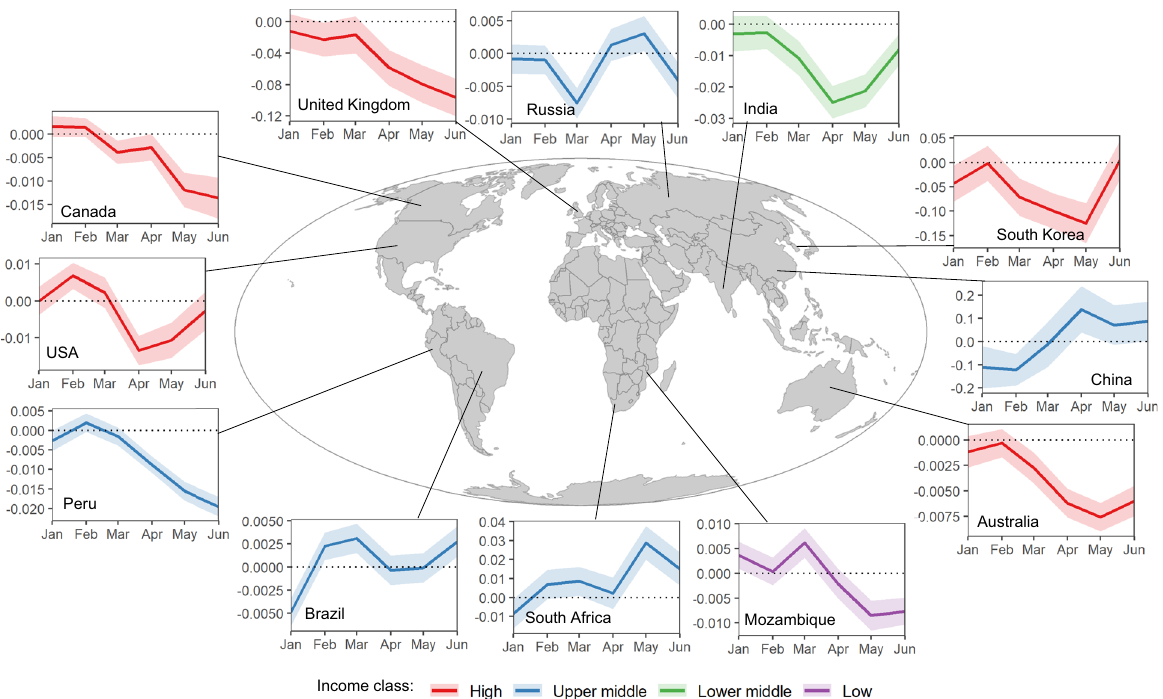
Fig. 7 Changes in marine traf fi c density in selected countries. Mean absolute change and standard deviation of marine traf fi c (number of vessel transits per square kilometre per month) estimated within country Economic Exclusive Zones (EEZ). Colour categories represent income classes from the World Bank. Change estimated in comparison with monthly densities from equivalent month from reference year